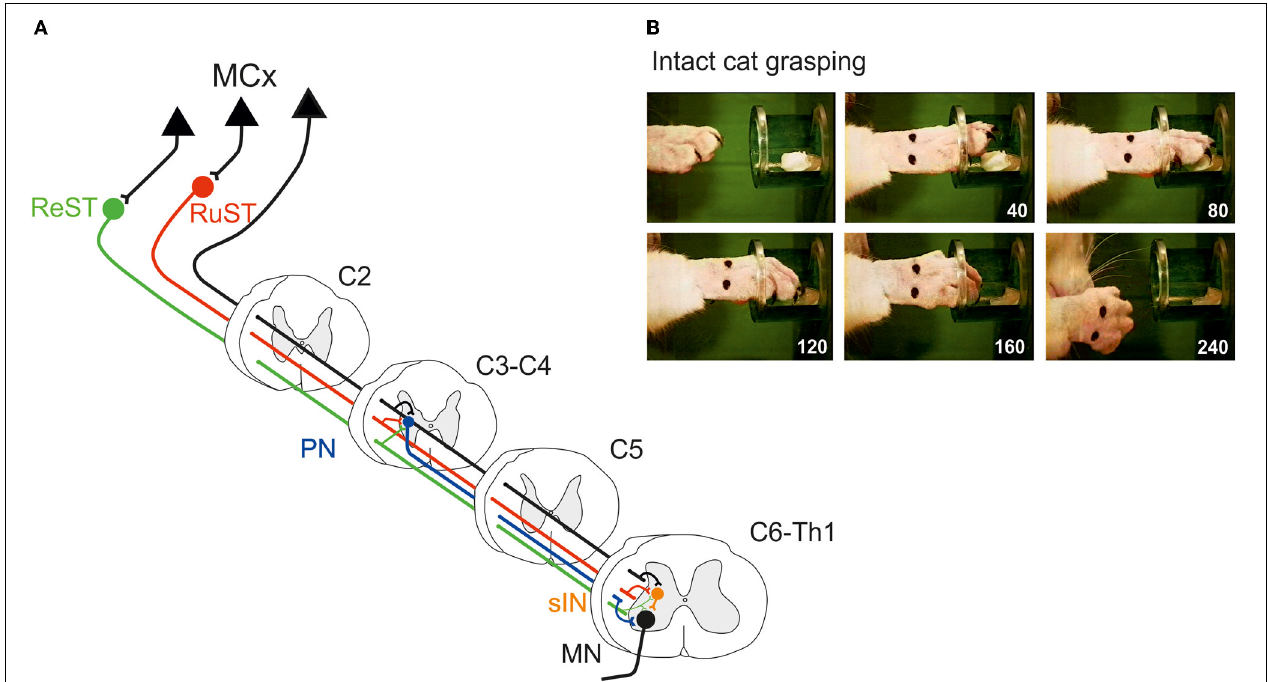
FIGURE 1 | (A) Spinal interneuronal systems for control of reaching and grasping movements in the cat. Propriospinal neurons (PNs, blue) in C3-C4 have been shown to mediate the command for reaching to forelimb motoneurones (MN) whereas digit grasping depend on transmission via segmental interneurons (sINs, orange) at the same spinal levels as the forelimb motoneurones (C6-Th1). The motor cortex (MCx) may control these interneuronal pathways via the Corticospinal- (CST, black) tract and, indirectly, via the Rubrospinal (RuST, red) and the